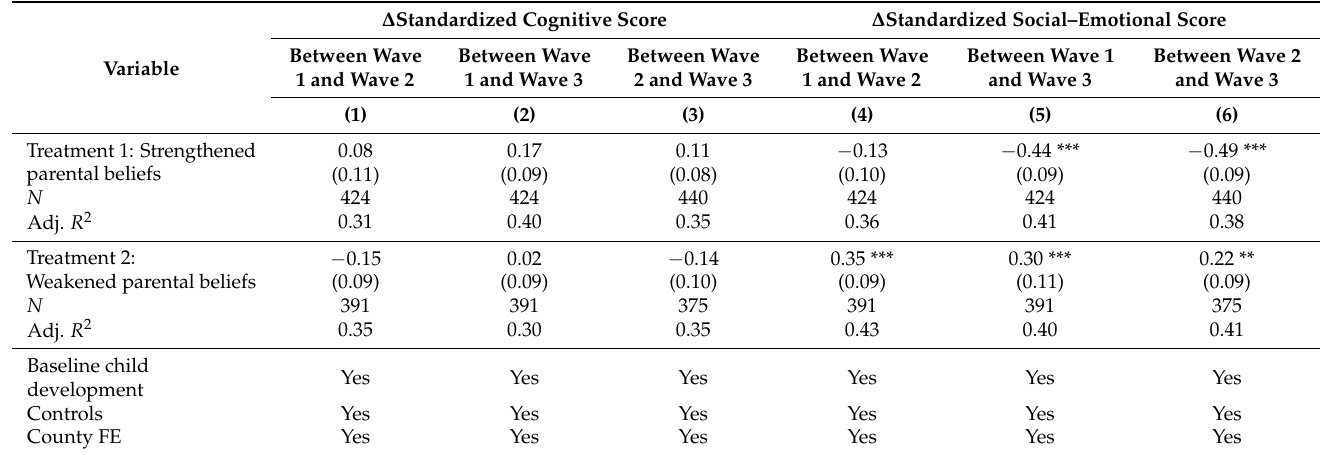
Table 4. DID analysis of the effect of strengthened and weakened parental beliefs on child develop- mental